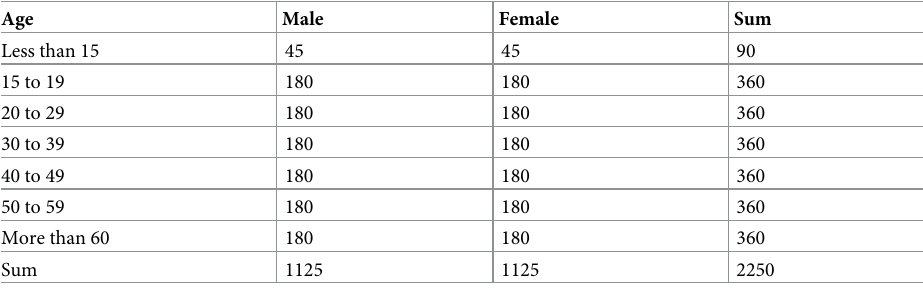
Table 2. Plan of the experiment for the number of subjects (short-term emotion).